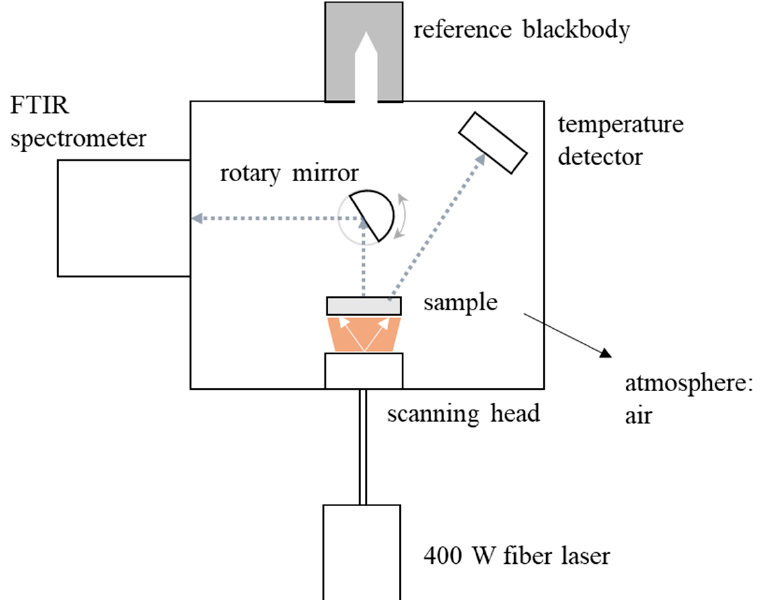
Figure 2. Schematic overview of the spectral normal emissivity measurement device at the New Technologies Research Center at the University of West Bohemia.